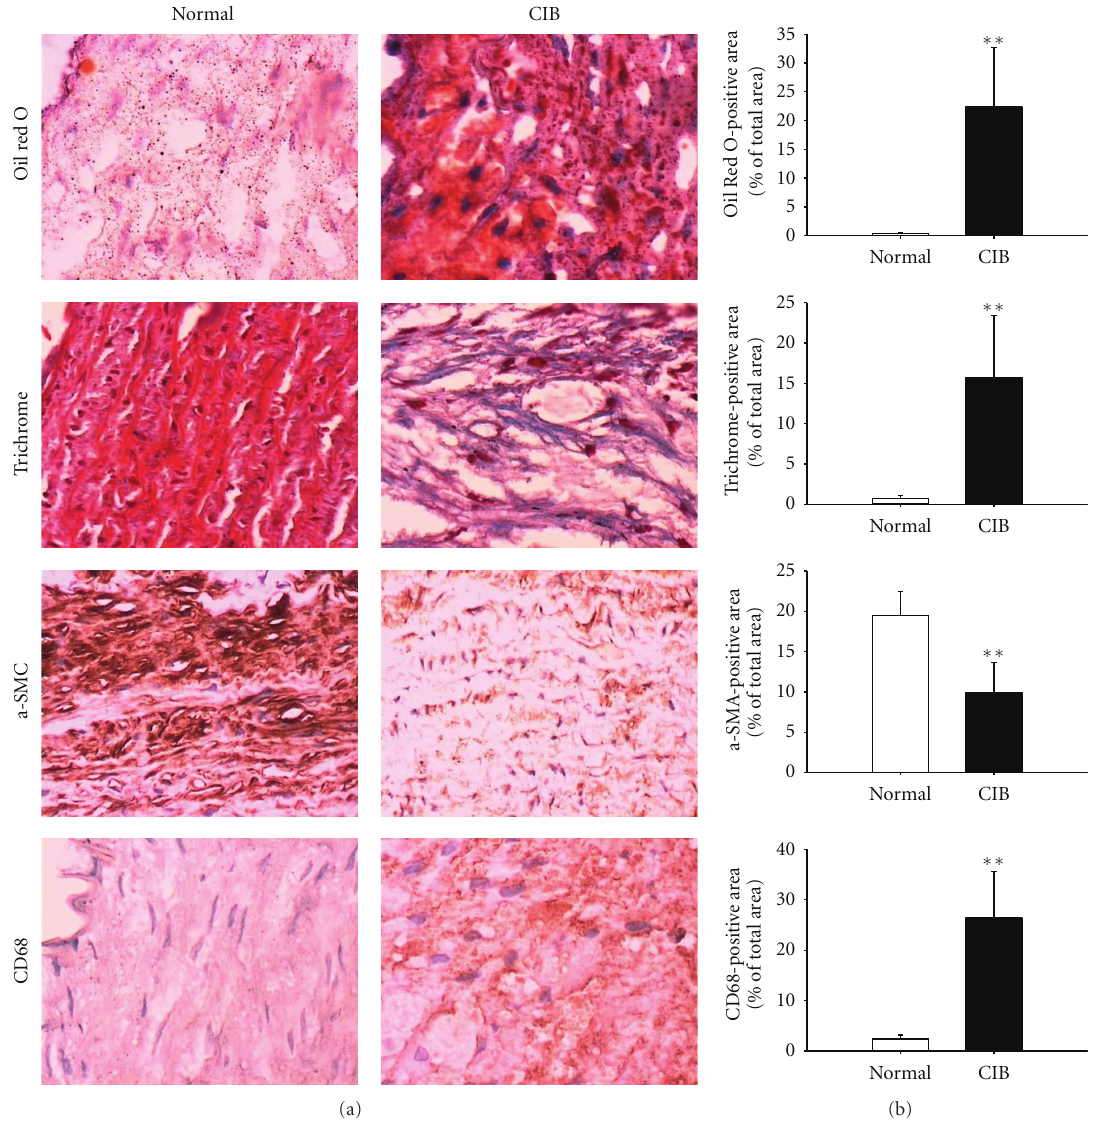
Figure 4: Vulnerability plaque has been identified on CIB rabbit. (a) Representative aortic sections stained by Oil red O, trichrome, CD68 antibody and a SMC-specific antibody (magnification × 40). (b) Quantification revealed a significantly larger lipid core, collagen, SMA- positive area, and the density of macrophages (identified by CD 68 immunostaining) in CIB rabbits. Data are expressed as mean ± SD, ∗∗ P < 0 . 01 compared with normal.